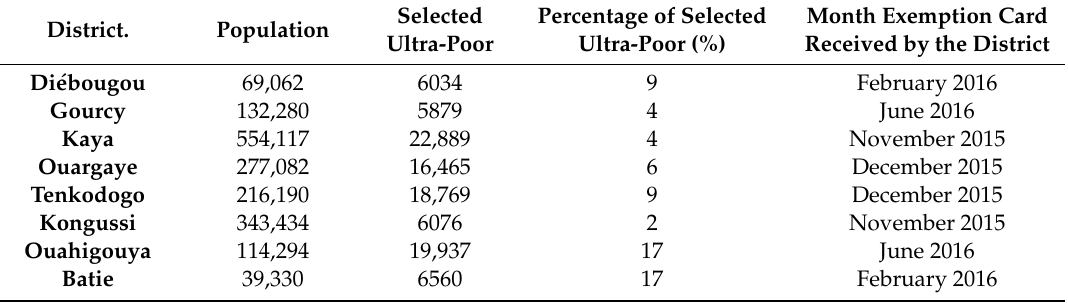
Table 1. Population, number and percentage of identified ultra-poor, and reception of exemption card by district. District. Population